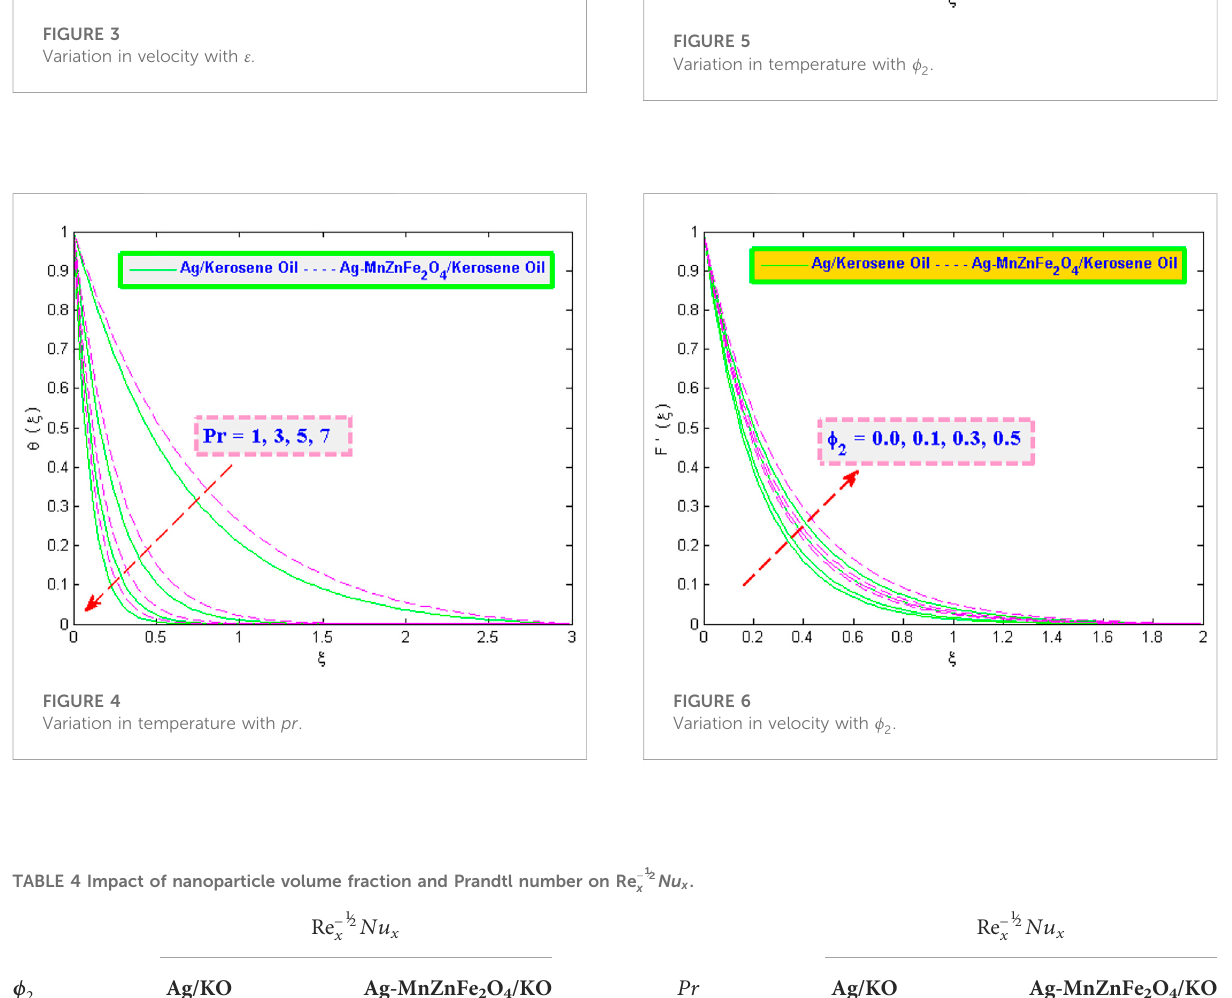
FIGURE 3 Variation in velocity with ε .